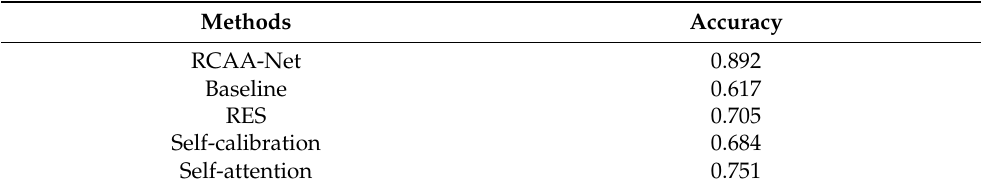
Table 3. The experimental ablation